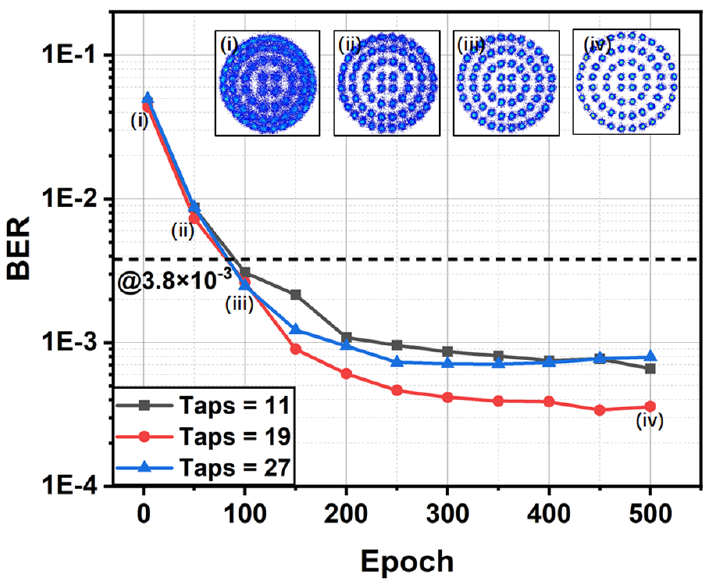
Figure 5. The relationship between BER performance of different taps and epoch during training. ( i – iv ) show the constellation points when epoch is 2, 50, 100 and 500, respectively. In order to analyze the effects of the DNN converter, more specifically, the BER versus different signal Vpp for 64APSK and 64QAM UVLC systems under the bias current of 150 mA is demonstrated in Figure 7, compared with traditional CAP demodulation. In terms of traditional CAP demodulation (black curves in Figure 7a,b), the BER decreases as the increase of signal Vpp when it is smaller than 450 mV due to the enhancement of SNR. When it is larger than 450 mV, the BER versus signal Vpp has an opposite tendency because of nonlinear distortions. Thus, the signal Vpp dynamic range of signal Vpp is 250 mV for 64APSK and 180 mV for 64QAM with 7% FEC of 3.8 × 10 − 3 , respectively. The communication performance is significantly improved by using DNN converter (red curves in Figure 7a,b), as the signal Vpp dynamic range enlarges by 104% (from 250 mV to 511 mV) for 64APSK in Figure 7a and 181% (from 180 mV to 506 mV) for 64QAM in Figure 7b. Meanwhile, the Q factor of 950 mA biases current increases by 3.12 dB for 64APSK and 2.96 dB for 64QAM, compared with traditional CAP demodulation. It is experimentally verified that the DNN converter has obvious advantages over traditional CAP demodulation in the nonlinear region, thus more suitable for UVLC systems. We also measured the Q factor for 64APSK and 64QAM UVLC systems at different bit rates under the optimal bias voltage and signaled Vpp with 7% FEC of 3.8 × 10 − 3 as a BER threshold. The performance of the DNN converter is in comparison with traditional CAP demodulation in Figure 8. As expected, the DNN converter could achieve greater communication capacity. To be specific, the highest bit rate is 3.23 Gb/s in the 64APSK system utilizing DNN converter and 3.09 Gb/s in 64QAM system, which is 125 Mb/s and 50 Mb/s faster than traditional CAP demodulation, respectively. 64APSK using the DNN converter is experimentally proved to be a promising scheme for future high-speed UVLC